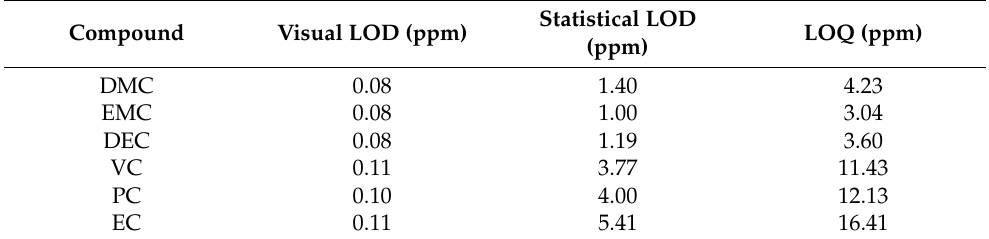
Table 4. Limit of detection (LOD) and limit of quantification (LOQ) of DMC, EMC, DEC, VC, PC, and EC when using GC × GC/FID.